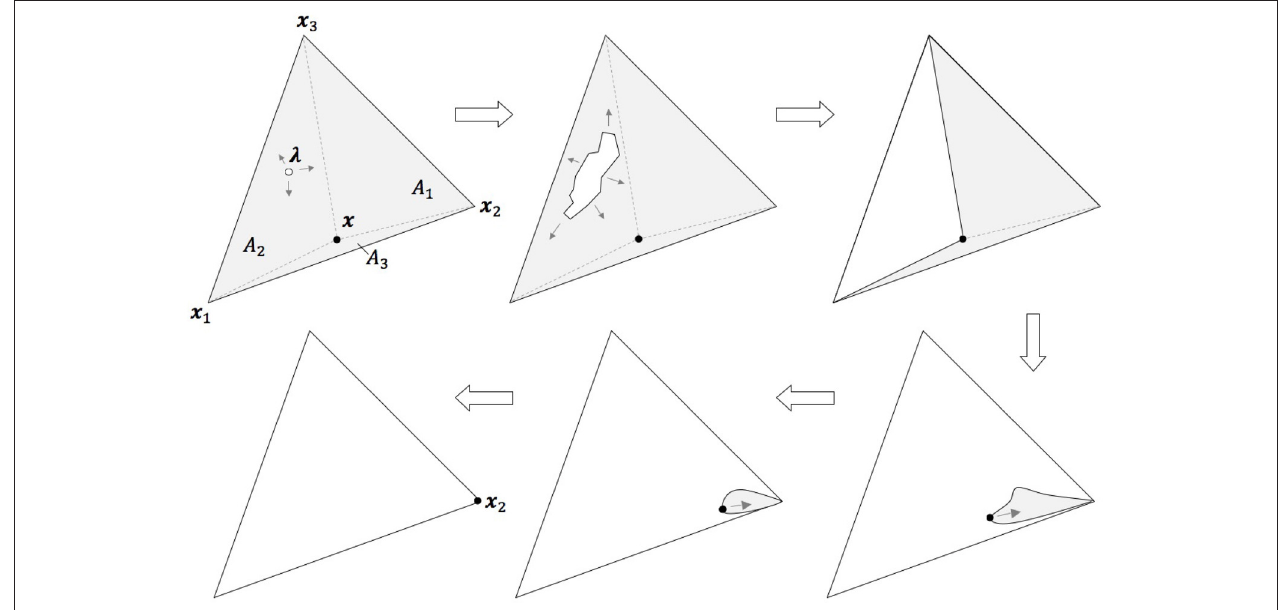
FIGURE 1 | A 2 -dimensional measurement simplex, considered as an abstract membrane stretched between the three vertex points x 1 , a x 2 , and x 3 , with the abstract point particle attached to it, at point x , giving rise to three disjoint convex regions A 1 , A 2 , and A 3 . The vector λ , here assumed to belong to region A 2 , indicates the initial point of disintegration of the membrane, which by collapsing brings the point particle to point x 2 , corresponding to the final outcome of the